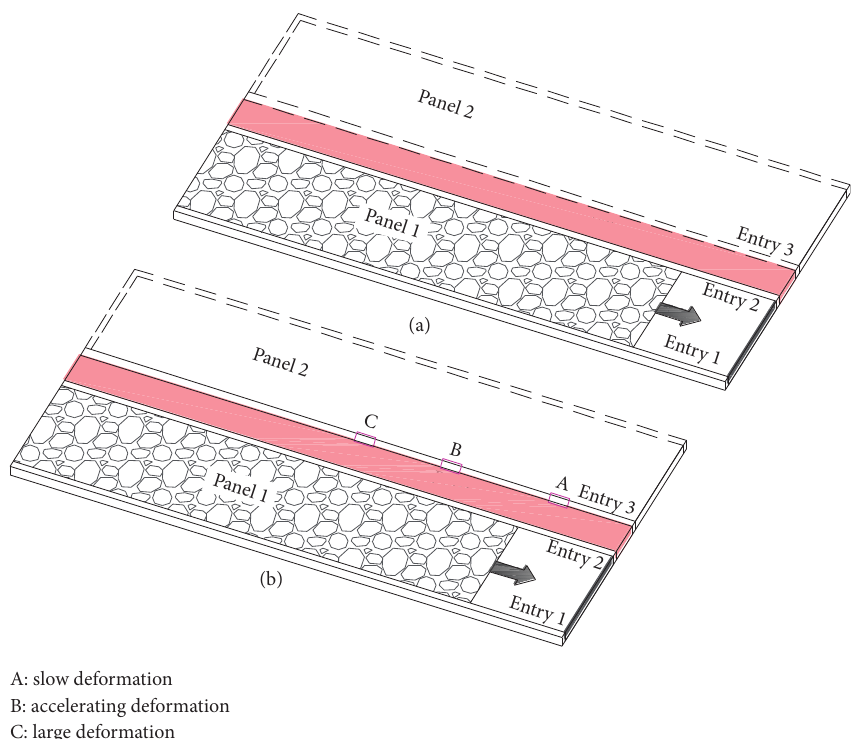
Figure 1: Sketch of typical longwall panel layout. (a) Single-lane layout. (b) Double-lane